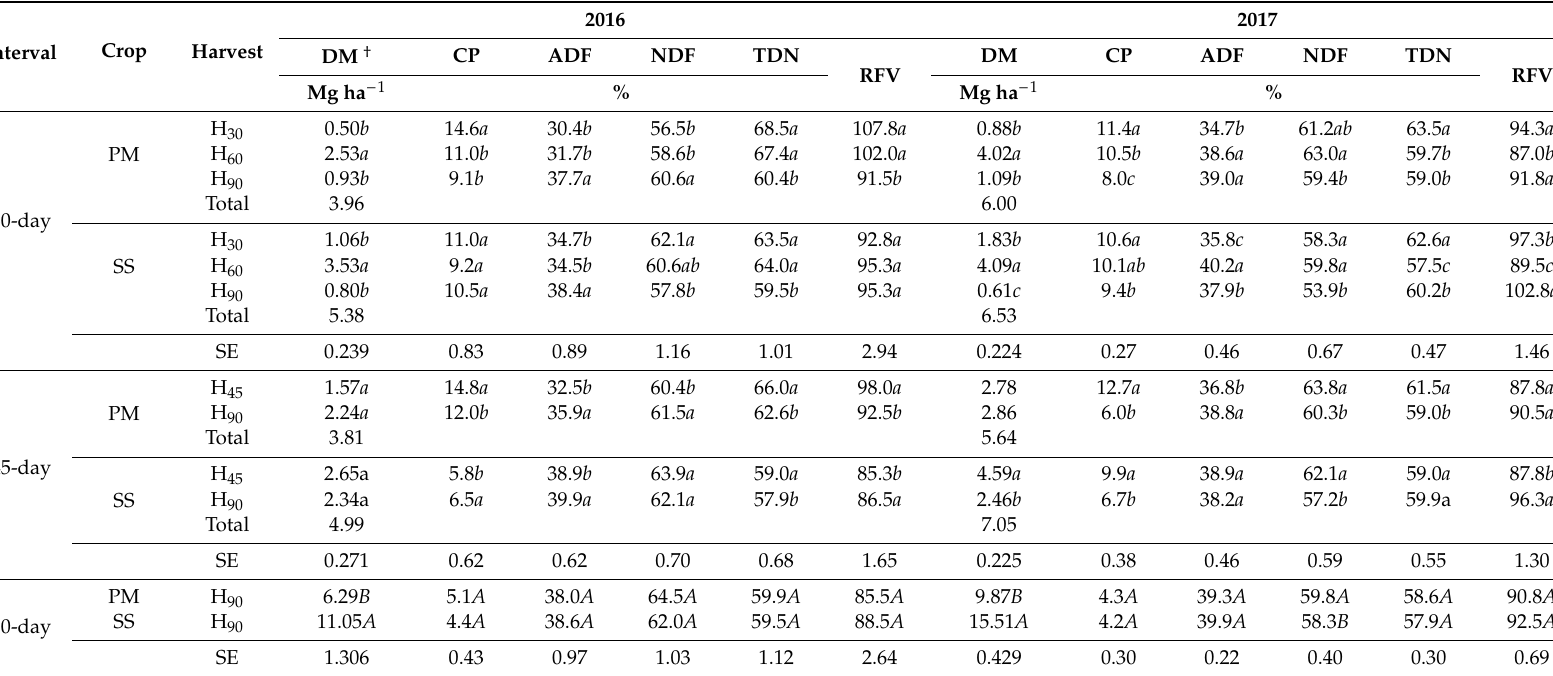
Table 2. Brown midrib (BMR) sorghum-sudangrass (SS) and BMR pearl millet (PM) aboveground dry matter (DM) and forage quality means for crude protein (CP), acid detergent fiber (ADF), neutral detergent fiber (NDF), total digestible nutrients (TDN), and relative feed value (RFV) near Canyon, TX, in 2016 and 2017. Harvest intervals included three 30-day, two 45-day, and one 90-day harvest for each